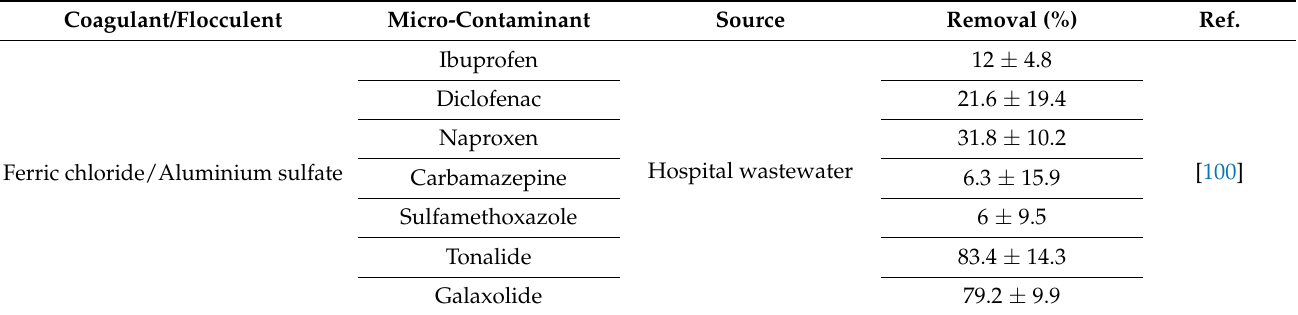
Table 3. Comprehensive data about the removal process of disparate micro-contaminants from various types of water/wastewater sources applying the G-F